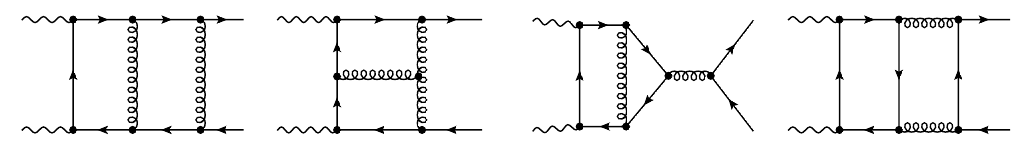
Figure 2: Sample Feynman diagrams.